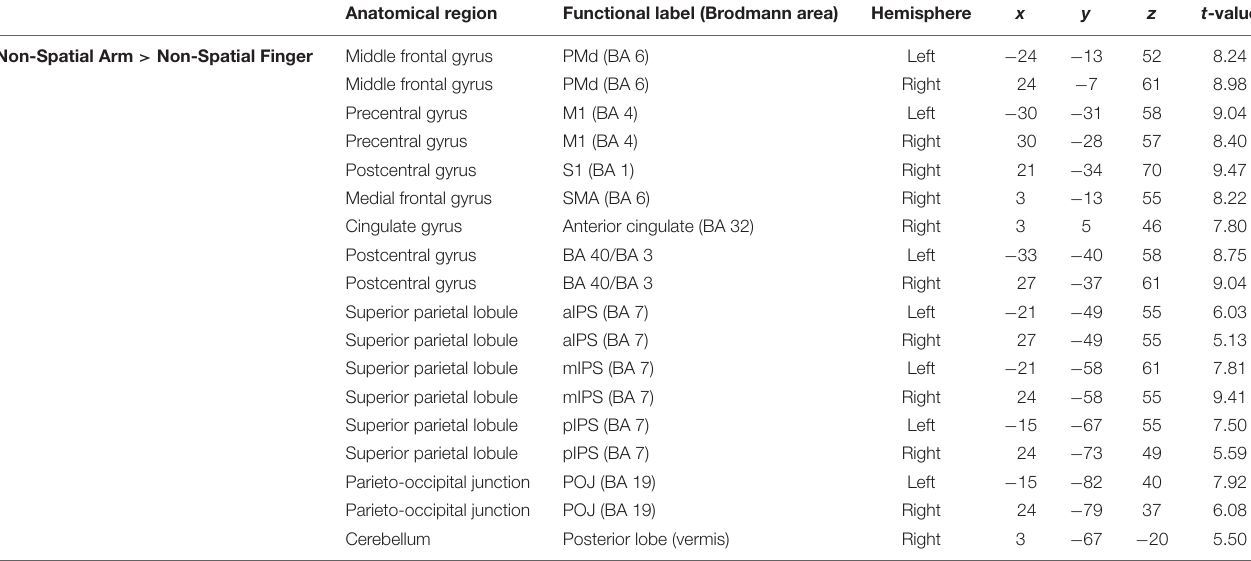
FIGURE 3 | fMRI BOLD response during Non-spatial reach preparation. Areas showing a significantly greater BOLD response in the Non-Spatial Arm as compared to the Non-Spatial Finger condition, overlaid on an inflated cortical surface ( p < 0.05 FDR; no significant activation for the reverse contrast Non-Spatial Finger > Non-Spatial Arm). TABLE 3 | Average MNI coordinates (in mm) of clusters showing significantly more activity in the Non-Spatial Arm as compared to the Non-Spatial Finger condition. Anatomical region Functional label (Brodmann